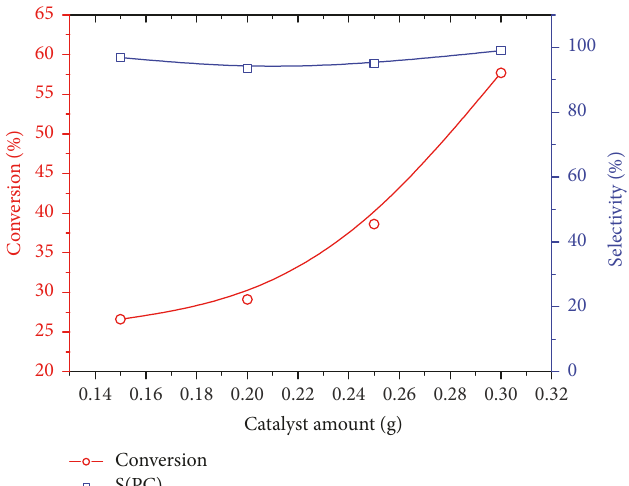
Figure 7: Effect of catalyst amount on the conversion and PC selectivity. Reactions carried out under 5-bar CO 2 pressure at 65 ∘ C during a period of 7 h. 𝑚 (catalyst)/ 𝑚 (cocatalyst) = 3.